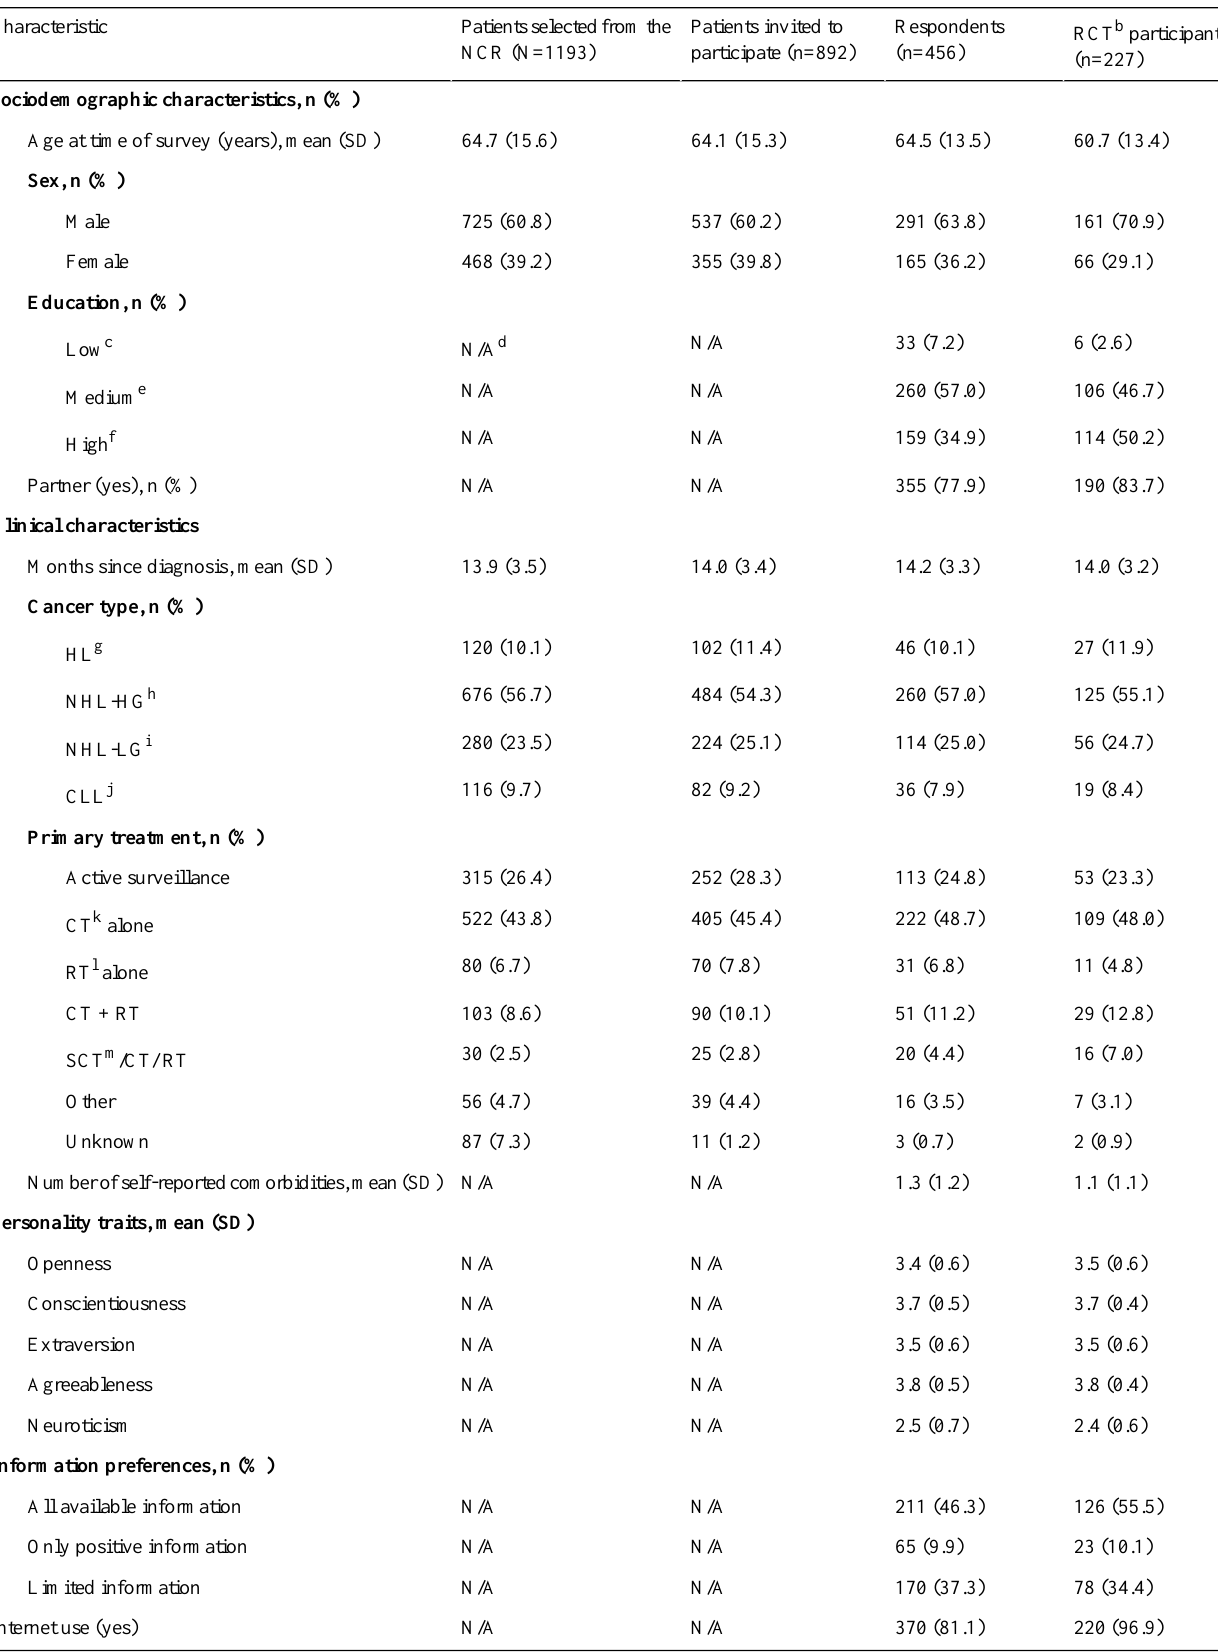
Table 1. Baseline characteristics of patients selected from the Netherlands Cancer Registry (NCR) according to participation a